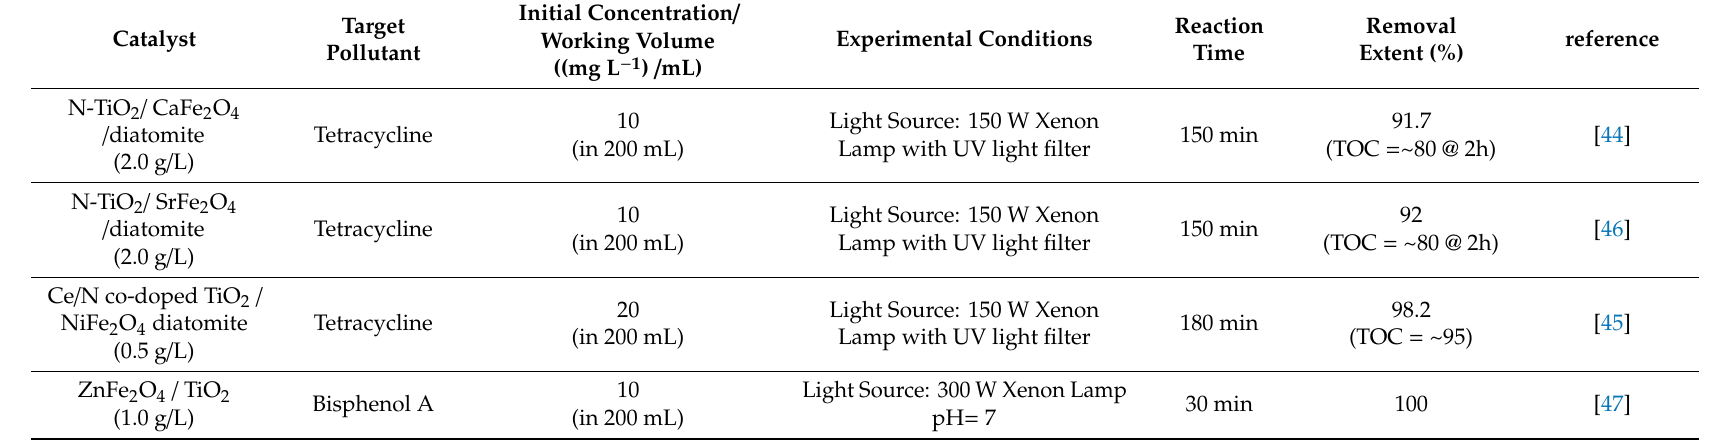
Table 3. Photocatalytic degradation of CEC’s over TiO 2 / MFe 2 O 4